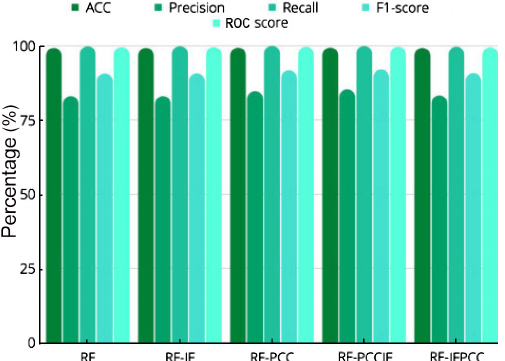
Fig. 11 Training time and prediction time consumed by our models on the NF-UNSW-NB15-v2 dataset.